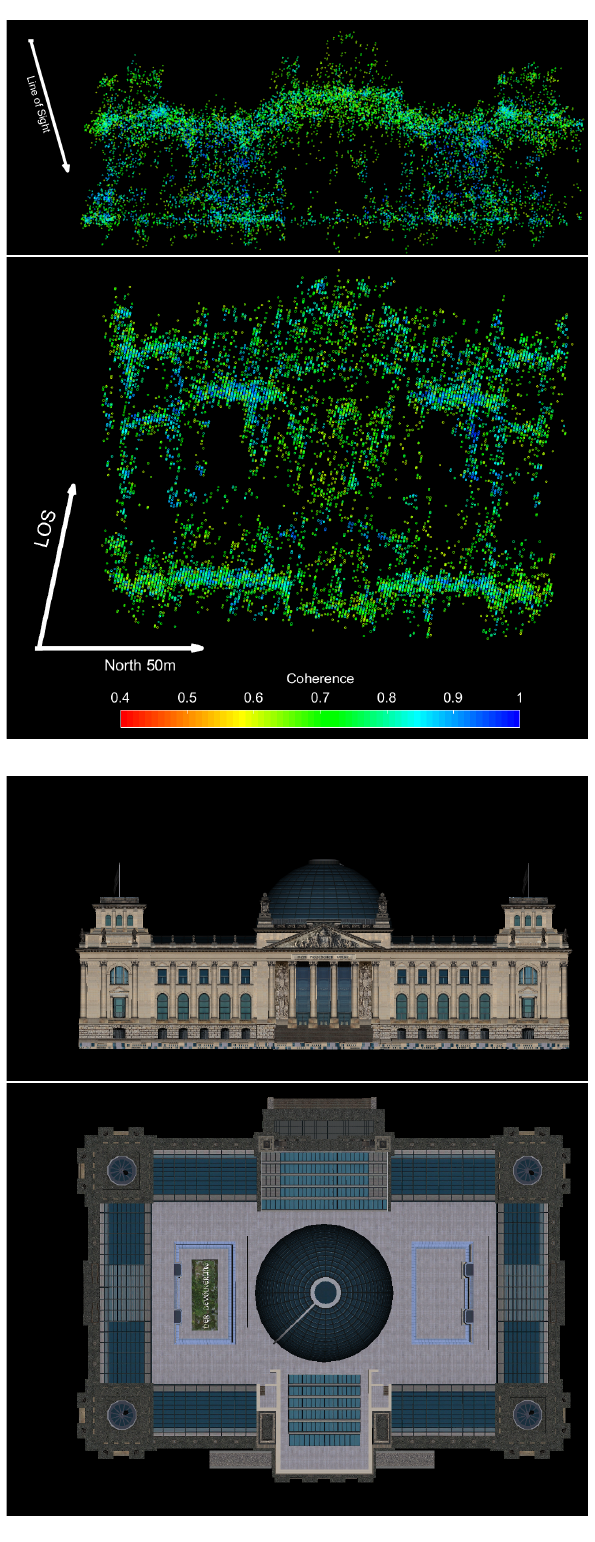
Figure 3. Top: PS-points with color coded coherence from side Figure 4. Manualy segmented mesh of the Berlin Reichstag - and top view. Bottom: Textured mesh of the same building (side each color indicates an individual and top view). Note that the PS-point density on the facades, towards the line-of-sight is is very dense. Also the steel structures on the roof lead to a high point density, with a high coherence value.